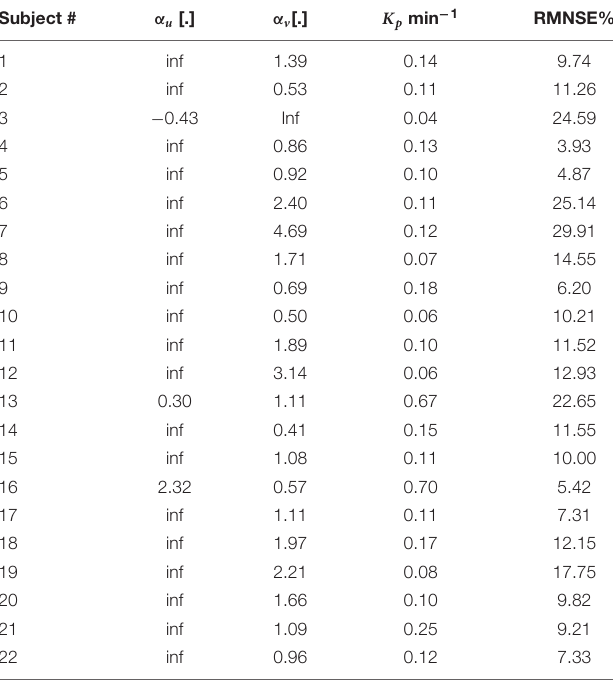
TABLE 2 | Calibration Results for three parameter